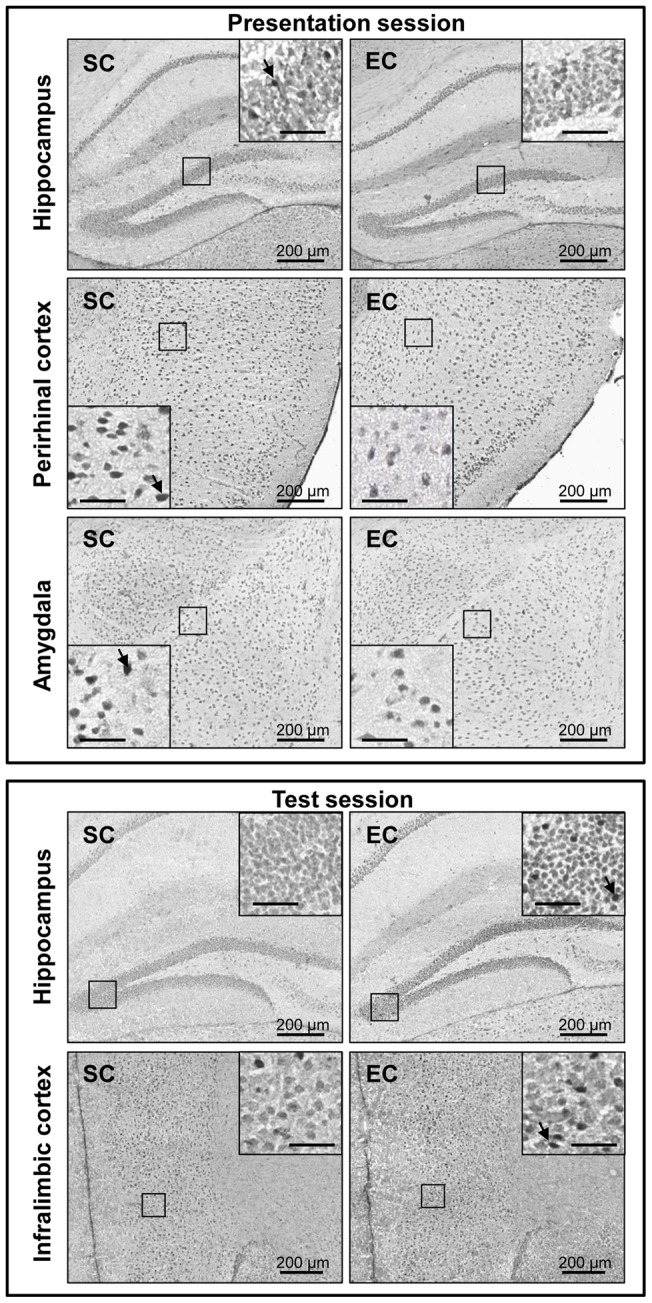
Microphotographs of brain c-Fos immunostaining related to the presentation and the test sessions.During the presentation session, the number of c-Fos-positive cells counted in the hippocampus (represented here by the granular cell layer of the dentate gyrus), the perirhinal cortex and the baso-lateral amygdala was lower in EC mice compared to SC ones. By contrast, the number of c-Fos-positive cells counted in the hippocampus and the infralimbic cortex during the test session was higher in EC mice. The dark arrows indicate examples of nuclei showing c-Fos immunoreactivity. Unannotated scale bars: 50 µm.